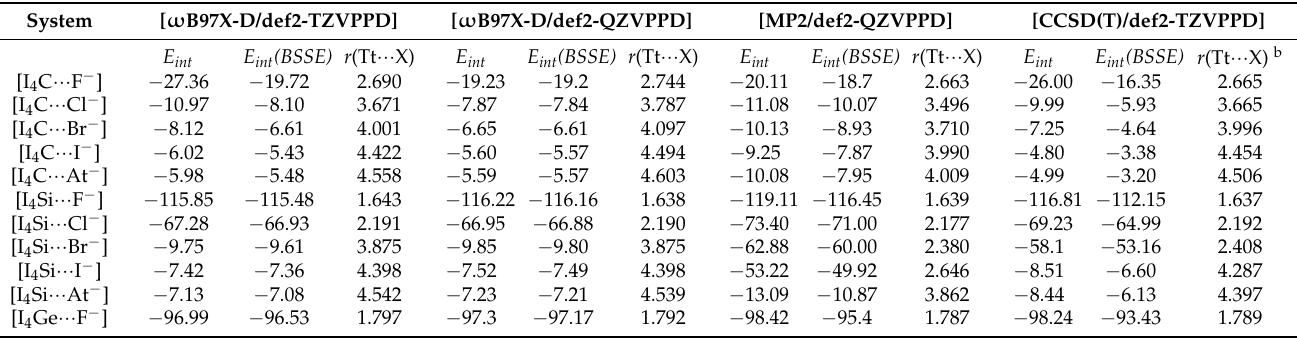
Table 2. Comparison of ω B97X-D and MP2 level intermolecular bond distances, uncorrected